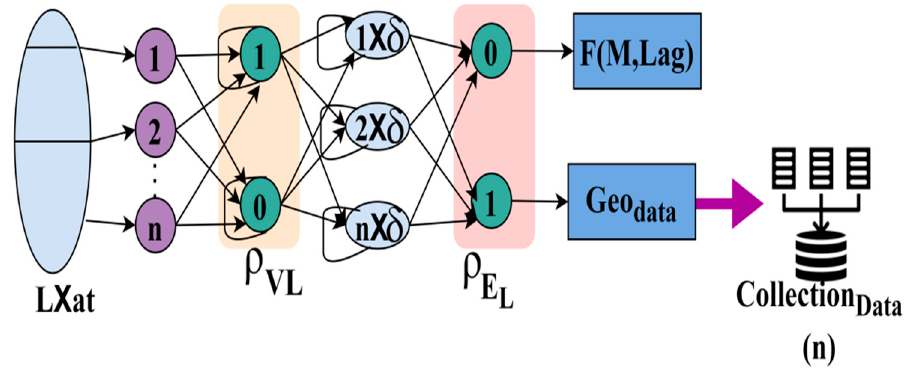
Figure 5. Extreme learning for lag estimation.